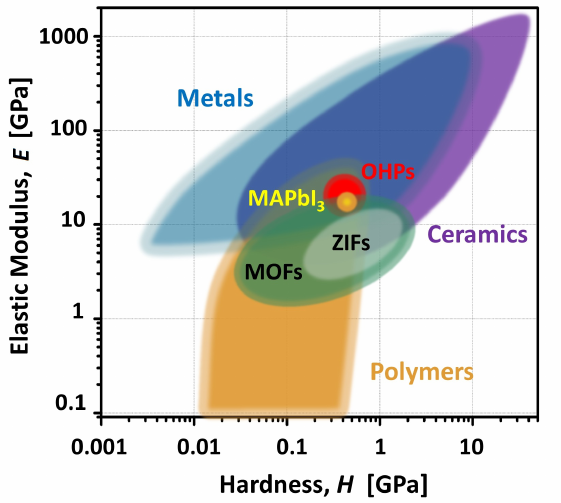
Figure 2. Color map of the elastic properties of several classes of materials around ambient conditions, including those discussed in the present and subsequent sections of this work. Please note the logarithmic scales of both vertical and horizontal axes. Adapted from Ref. [74] with permission from The Royal Society of